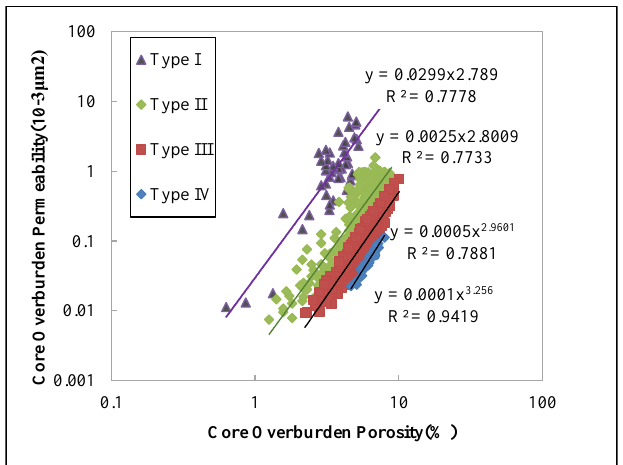
Figure 8. The relationship between core overburden permeability and porosity after classification of reservoirs based on FZI.